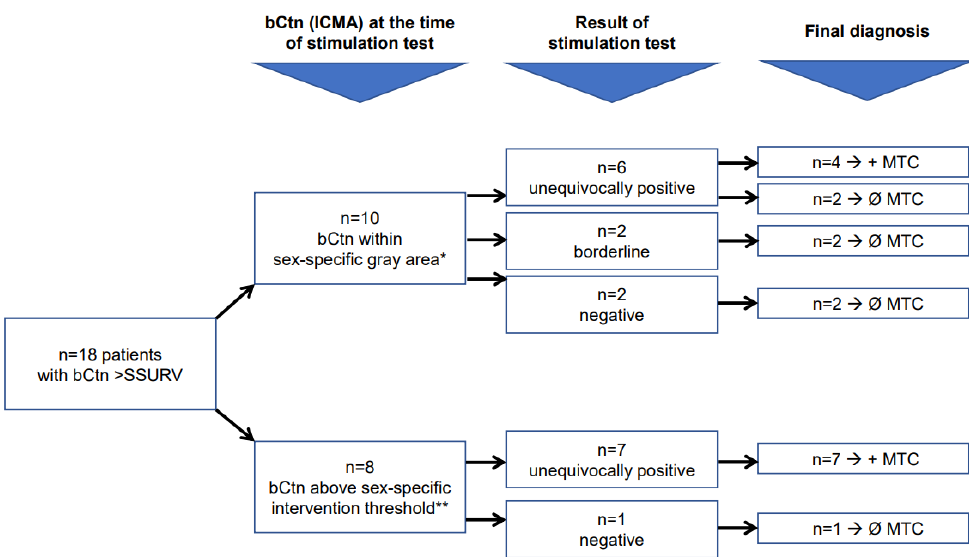
Figure 3. Comparison between basal Ctn values (bCtn, measured with the ICMA at the time of the stimulation test) and the results of the calcium gluconate stimulation tests. SSRUV = sex-specific upper reference values; * sex-specific gray area: SSRUV—30 pg/mL in females, SSRUV—60 pg/mL in males; ** sex-specific intervention threshold: 30 pg/mL in females and 60 pg/mL in males. In 10 of the above 18 patients (5 f, 5 m), the ICMA measured bCtn values at the time